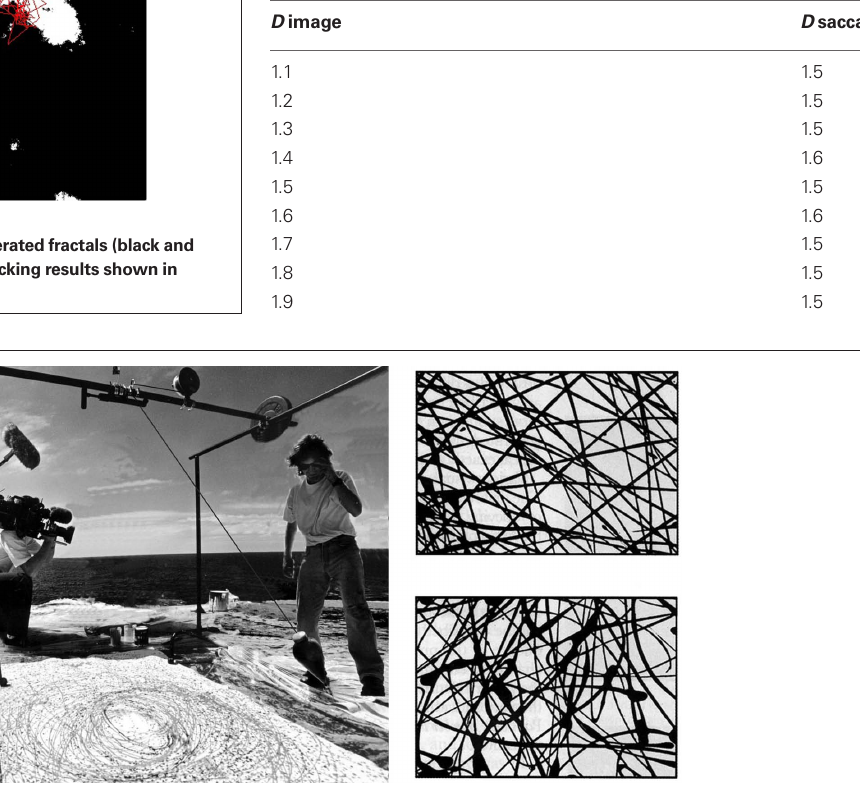
FiGurE 7 | The chaotic pendulum (left) employed to generate non-fractal (top right) and fractal (bottom right) poured paintings. This technique was documented by ABC television in